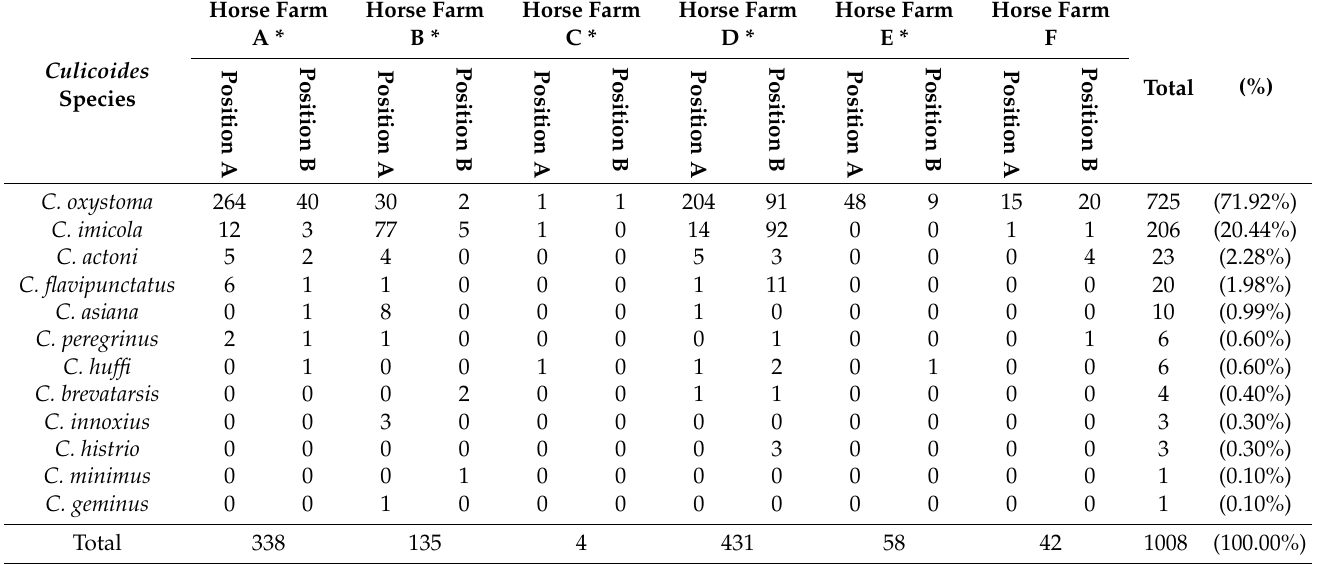
Table 2. Identification of Culicoides species in horse farms in Hua Hin district, Prachuab Khiri Khan province,